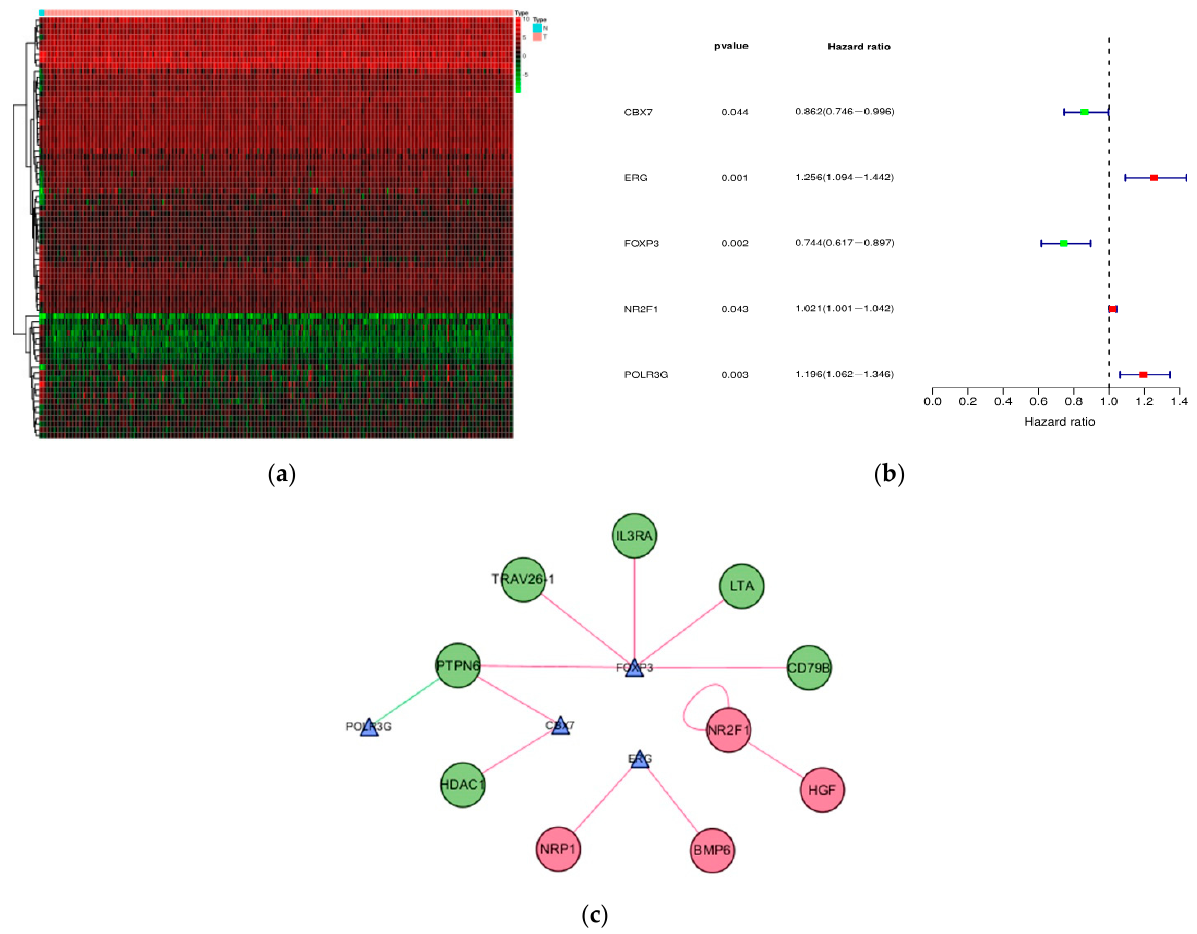
Figure 5. The construction of a regulatory network between SDETFs and SIRGs. ( a ) Heatmap of the SDETFs. ( b ) A forest plot of hazard ratios. The left is the list of SDETFs and their prognostic values showing as name, p ‐ value, and the hazard ratio (95% CI), and the right is the relevant forest plot. Green bar, protective factor; red bar, adverse factor. ( c ) A regulatory network between SDETFs and SIRGs. Triangle, TFs; Roundness, SIRGs; Red roundness, the overexpressed SIRGs; Green roundness, down ‐ expressed SIRGs. Red line, the TFs up ‐ regulate SIRGs; Green line, the TFs down ‐ regulate SIRGs.